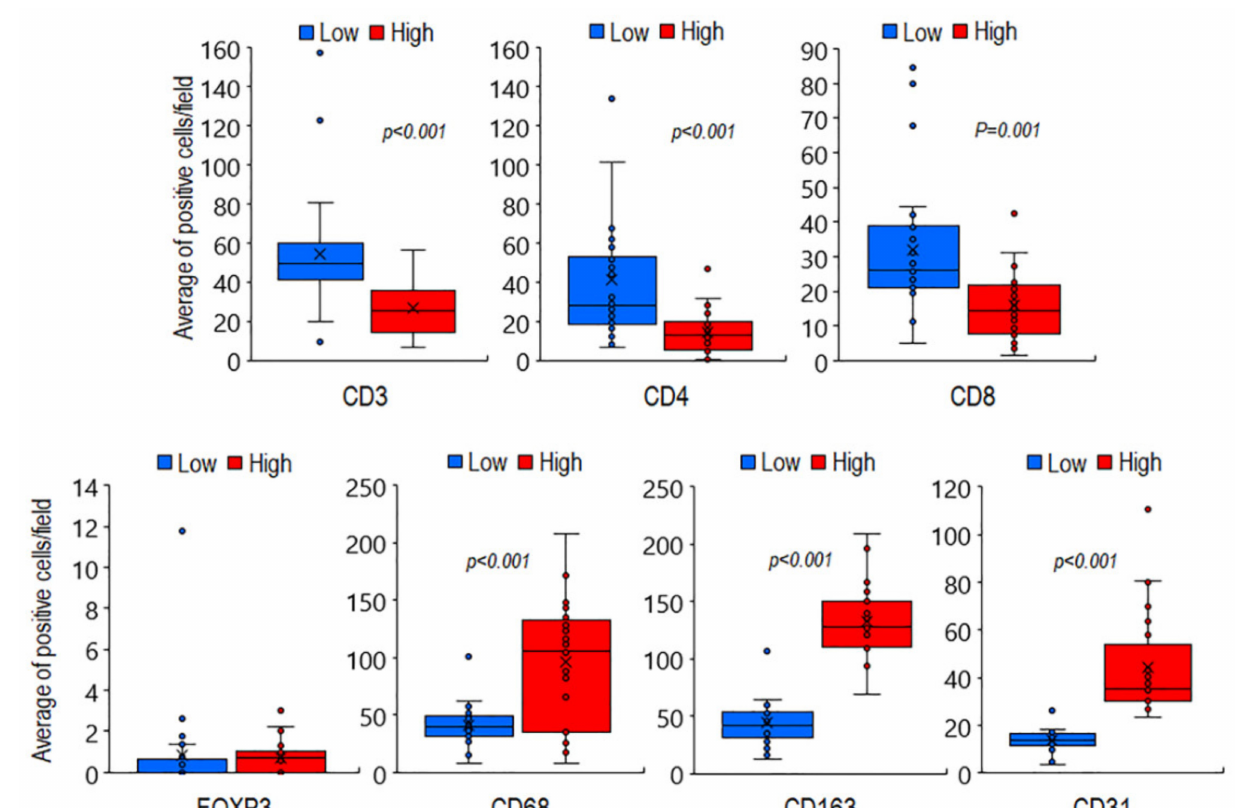
Figure 2. Correlation between immune cell infiltration and microvessel density in 26 low grade versus 24 high grade MLPS tissues. Box plots, showing variation in the average count of CD3+, CD4+, CD8+, FOXP3+, CD68+, and CD163+ cells as well as CD31 positive microvessels according to low or high histologic grade. Dark horizontal lines indicate the medians. Circles indicate